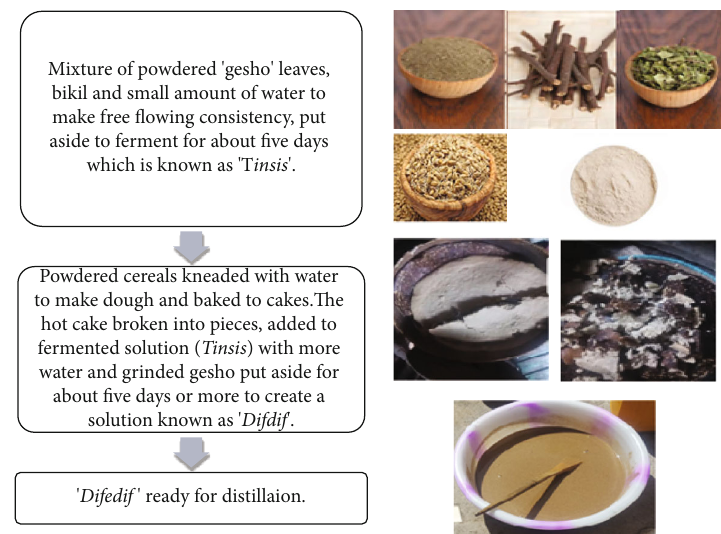
Figure 1: “ Difdif ” preparation process and its ingredients.